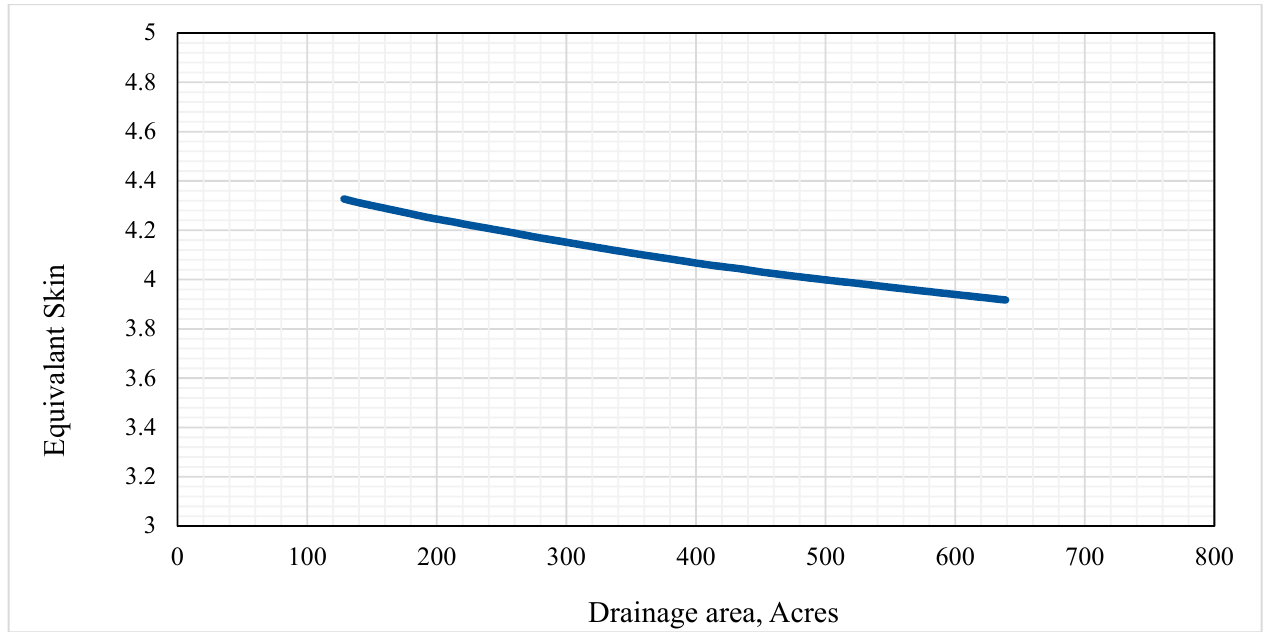
Figure 11. Equivalent skin factor versus drainage area.